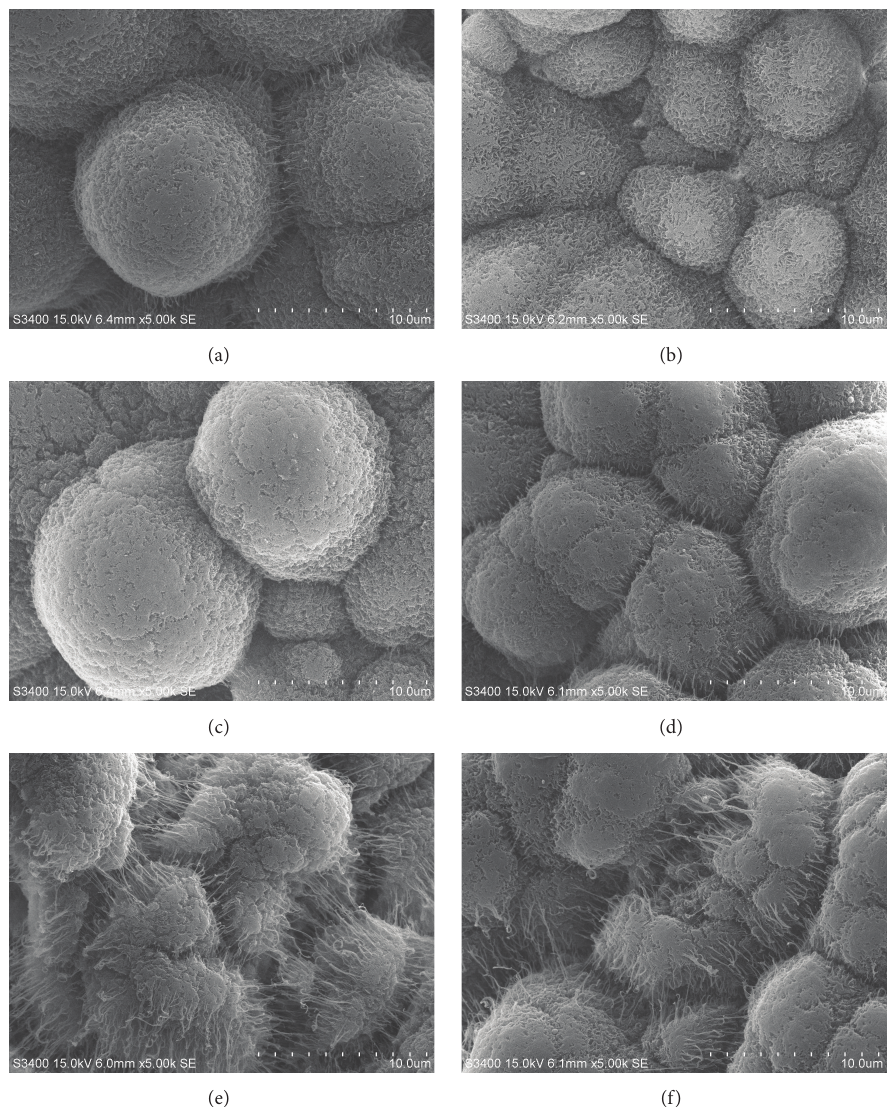
Figure 4: SEM images of the polyethylene obtained by (a) None-THF, (c) Al-THF, and (e) Fe-THF in the absence of H 2 and (b) None-THF, (d) Al-THF, and (f) Fe-THF at H 2 /C 2 H 4 molar ratio =